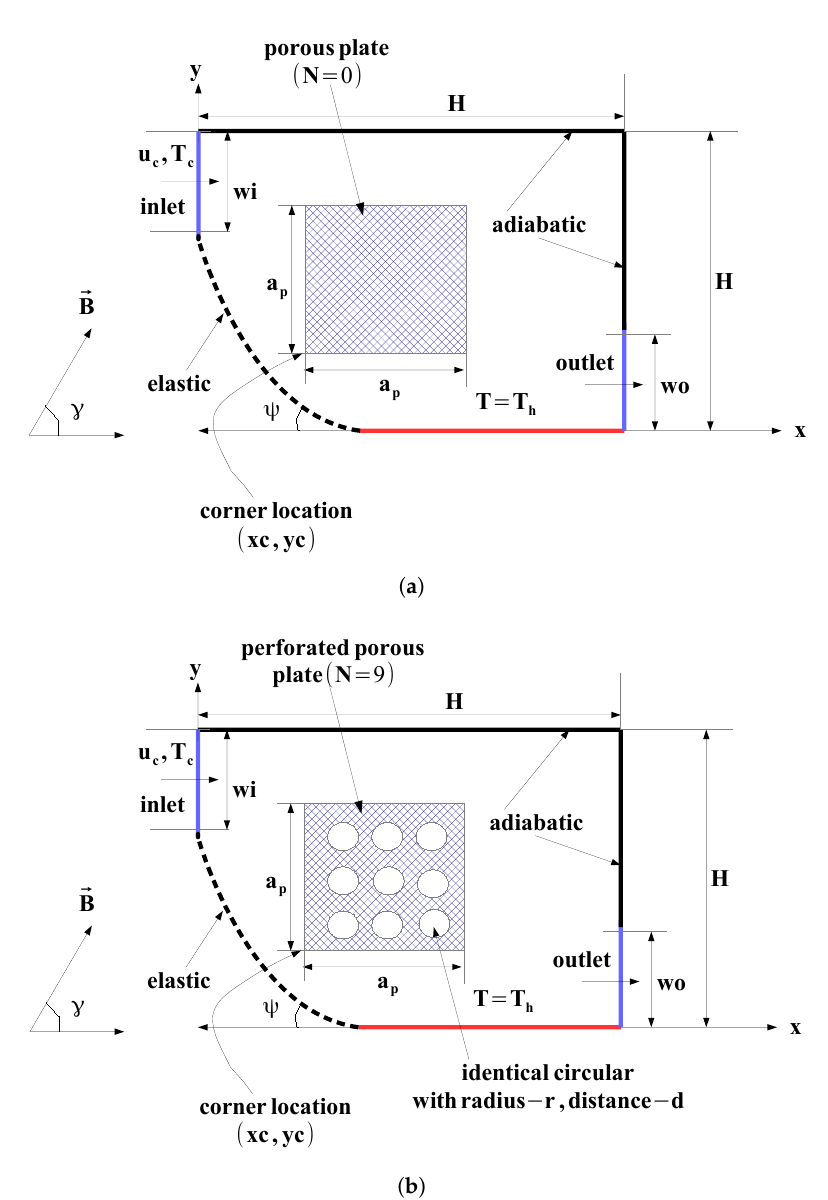
Figure 2. Different configurations of VC system with PP ( a ) and with PPP ( b